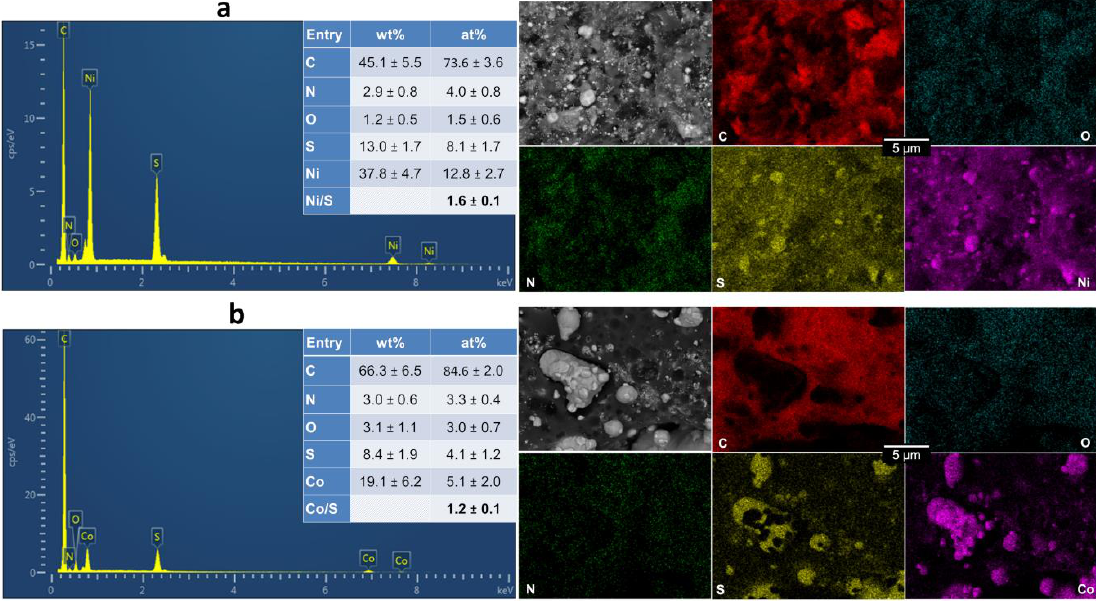
Figure 6. Materials obtained after polymerization (5 °C, 13 h), stabilization (air, 350 °C, 2 h) and calcination (N 2 , 900 °C, 6 h): EDX spectra, backscattered SEM images plus EDX maps of: ( a ) PANI- Ni-TS-TC, and ( b ) PANI-Co-TS-TC.